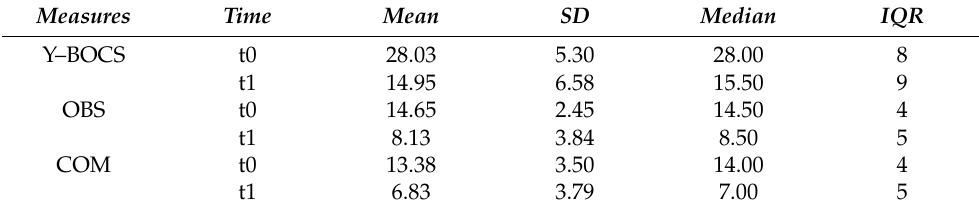
Table 4. Descriptive statistics. Means, standard deviations, median and inter-quartile range (IQR) of the total score of the Yale–Brown obsessive–compulsive scale (Y–BOCS) and of the related obsession (OBS) and compulsion subdimensions (COM), before (t0) and after (t1) the treatment. Measures Time Mean SD